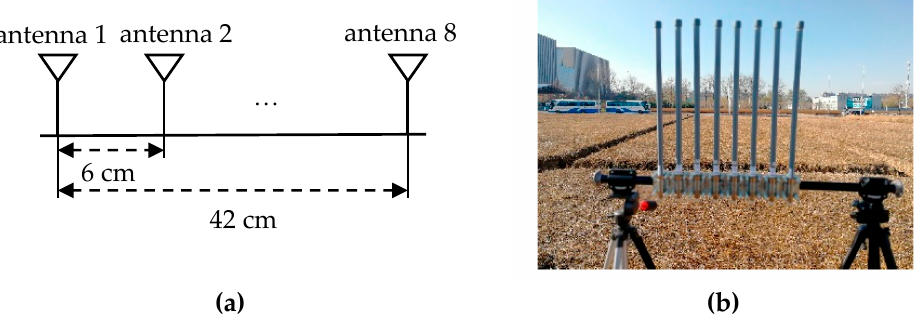
Figure 8. Eight-antenna uniform linear array: ( a ) schematic diagram; ( b ) physical